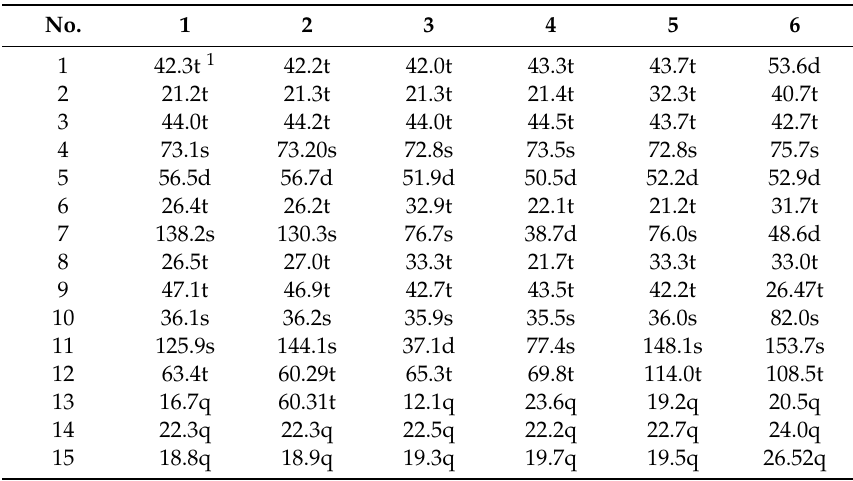
Table 2. 13 C-NMR spectral data of 1 – 6